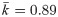
Effect of contact heterogeneity on strain richness.Comparison between a homogeneous (HOM) and a heterogeneous (HET) network. In HOM all nodes have the same activity rate aH = 0.285 and the network average degree is k¯=0.89. In HET the activity rate of each node is drawn randomly from a power-law distribution with support (ϵ, 1] and the same average value as in HOM. Lower values of the power-law exponent γ correspond to a higher contact heterogeneity. The average degree is the same as in HOM. We chose a population of V¯=306 individuals, average length of stay τ = 10 days, probability of strain injection per incoming individual ps = 0.079, and recovery rate μ = 0.00192 (see Materials and methods). (A) Sample time series of strain abundance for HOM and HET with γ = 0.7. Each time series is represented with a different color. All abundances are stacked together, so that plot’s height represents prevalence. Here β = 0.02. (B) Average prevalence vs β, and (C) average richness vs β. Two levels of heterogeneity are here considered for HET. For the sake of visualization, the shaded area corresponding to the standard deviation is shown only for HOM. Median and confidence intervals are reported in S1 Fig of the supporting information. (D) Average prevalence vs richness. Dashed lines are shown as a guide to the eye, highlighting variation in richness induced by network topology.